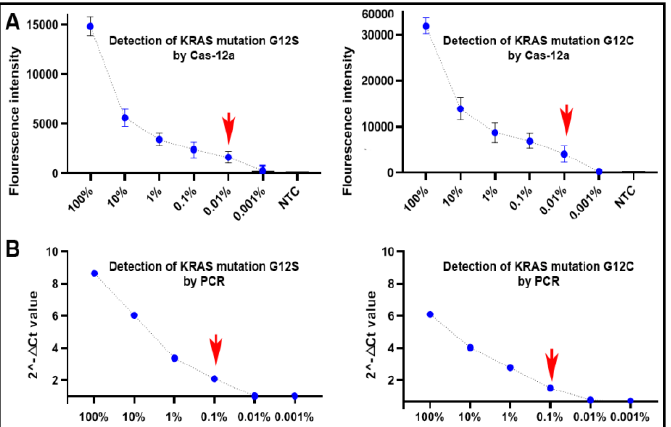
Figure 3. The dynamic ranges and sensitivities of CRISPR–Cas12a and PCR for the detection of KRAS mutations in serially diluted samples with different proportions of mutant KRAS DNA and wild-type KRAS DNA in the DNA of peripheral blood mononuclear cells (PBMCs) of a healthy donor: ( A ) CRISPR–Cas12a had a dynamic range of five orders of magnitude from 0.01% to 100% with a limit of detection (LOD) of 0.01% in the detection of the mutations; ( B ) PCR had a dynamic range of four orders of magnitude ranging from 0.1% to 100% with an LOD of 0.1%. The red arrow indicates the LOD of the tests. NTC, negative template control.